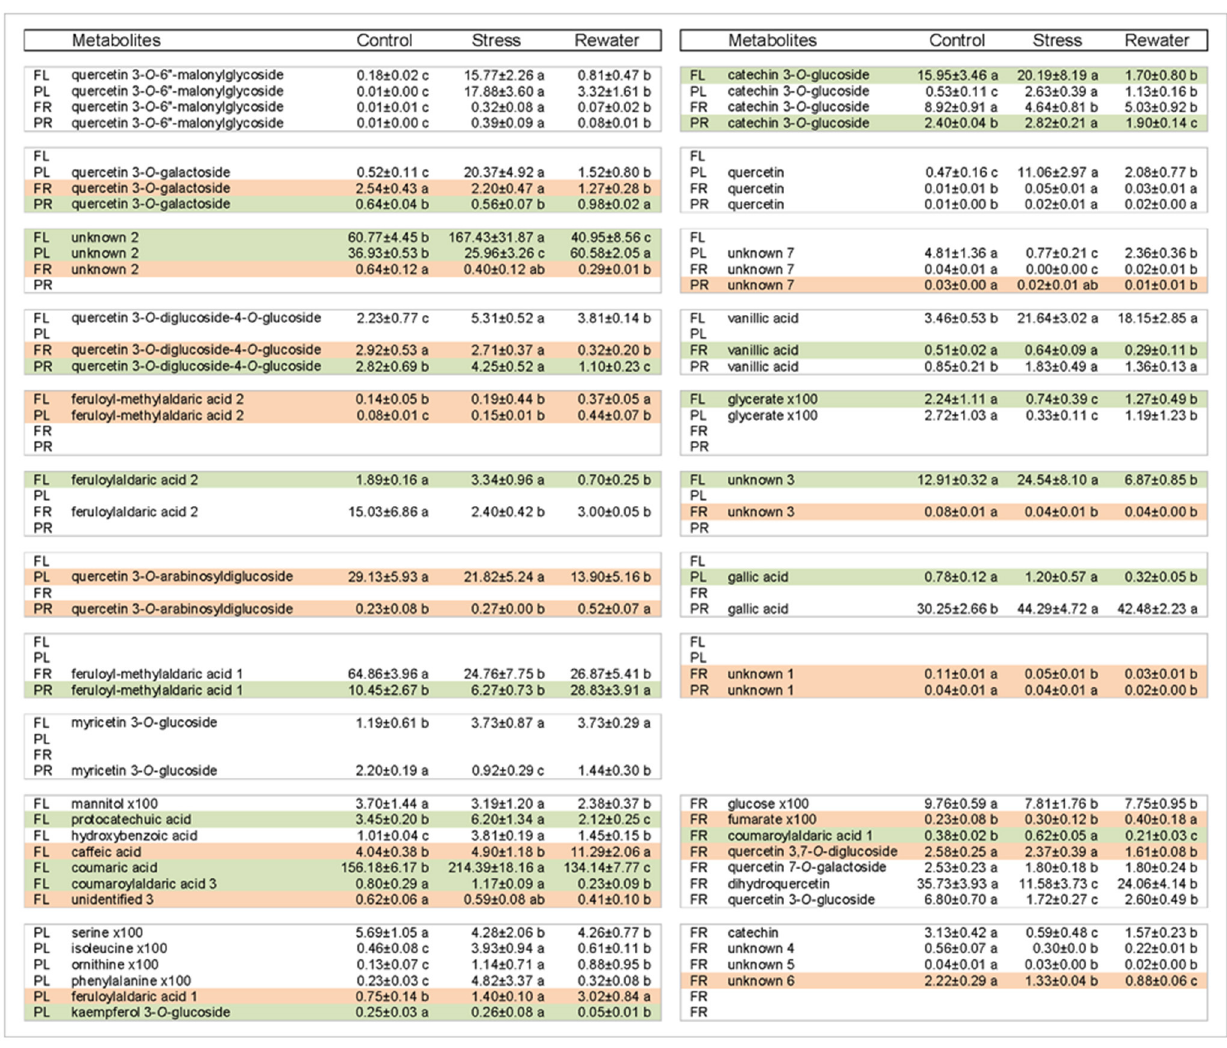
FIGURE 8 | Recovery performance of cowpea metabolites upon rewatering 12 days after drought stress. Shown are metabolites whose levels differed between well-watered control and rewatered plants. The letters indicate cultivars: PL for Pinhel leaves, PR for Pinhel roots, FL for Fradel leaves, and FR for Fradel roots. White, compounds that did not fully recover; Green, compounds that overcorrected compared to the control; Red, compounds that continuously changed. Normalized relative values for primary metabolites are multiplied by 100 for easier comparison. Different letters inside the rows denote statistical differences between means (Tukey’s test; P <